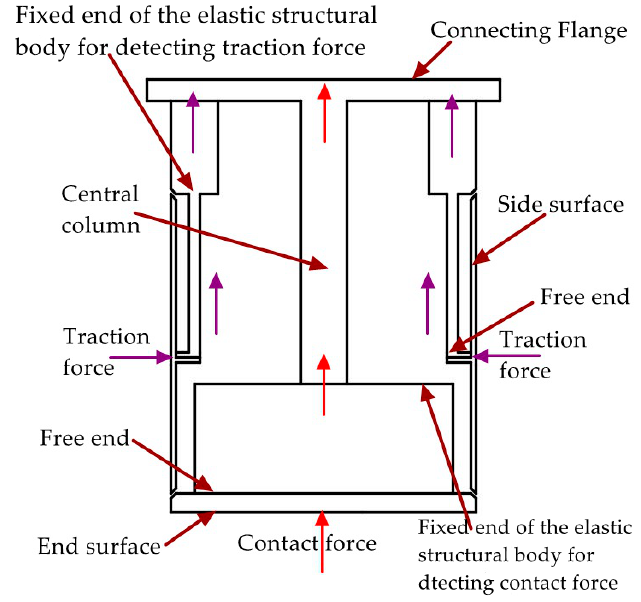
Figure 2. Simplified schematic diagram of series connection mode of the tandem force sensor.